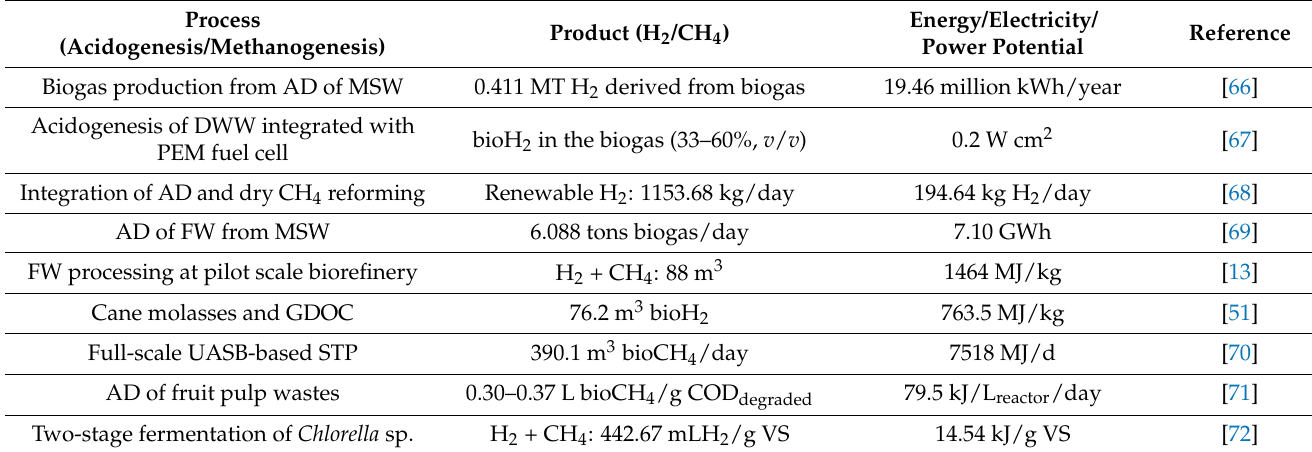
Table 1. Energy potential of biohydrogen and biomethane derived from various